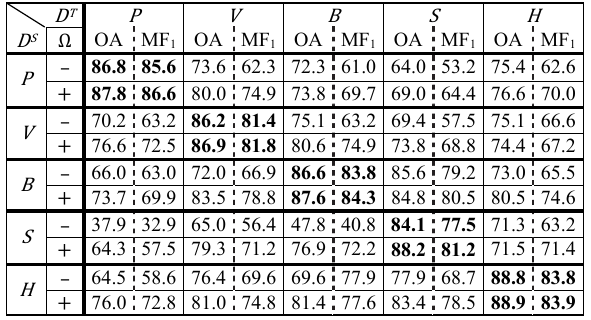
Table 3: Quality metrics in (cid:4670)%(cid:4671) of non-adapted models, trained on D S and evaluated on the test set of D T .